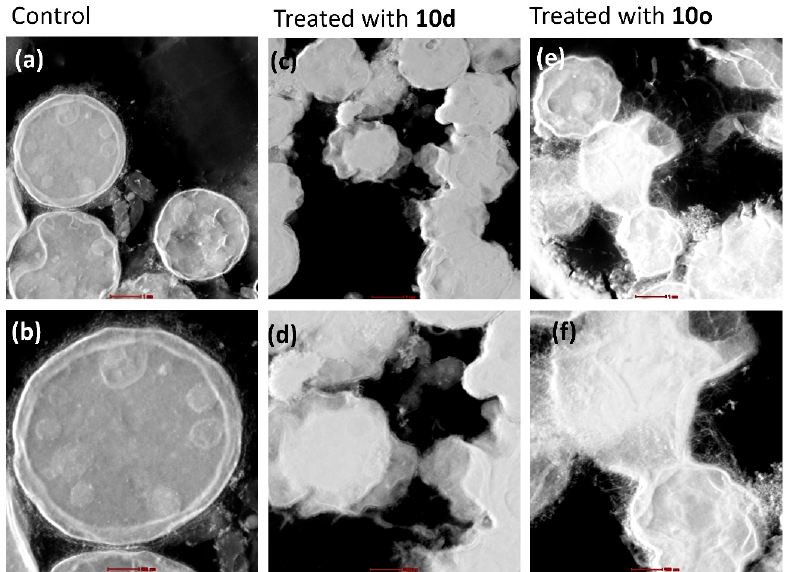
Figure 8. Morphological study of C. neoformans cells and cells treated with bioactive peptides by STEM. Images ( a , b ) represent the morphology of untreated/healthy cells; images ( c , d ) represent the cells treated with 10d ; and images ( e , f ) represent the cells treated with 10o . The scale bar for images ( a , c , e ) is 1 μ m and for images ( b , d , f ) it is 0.5 μ m.